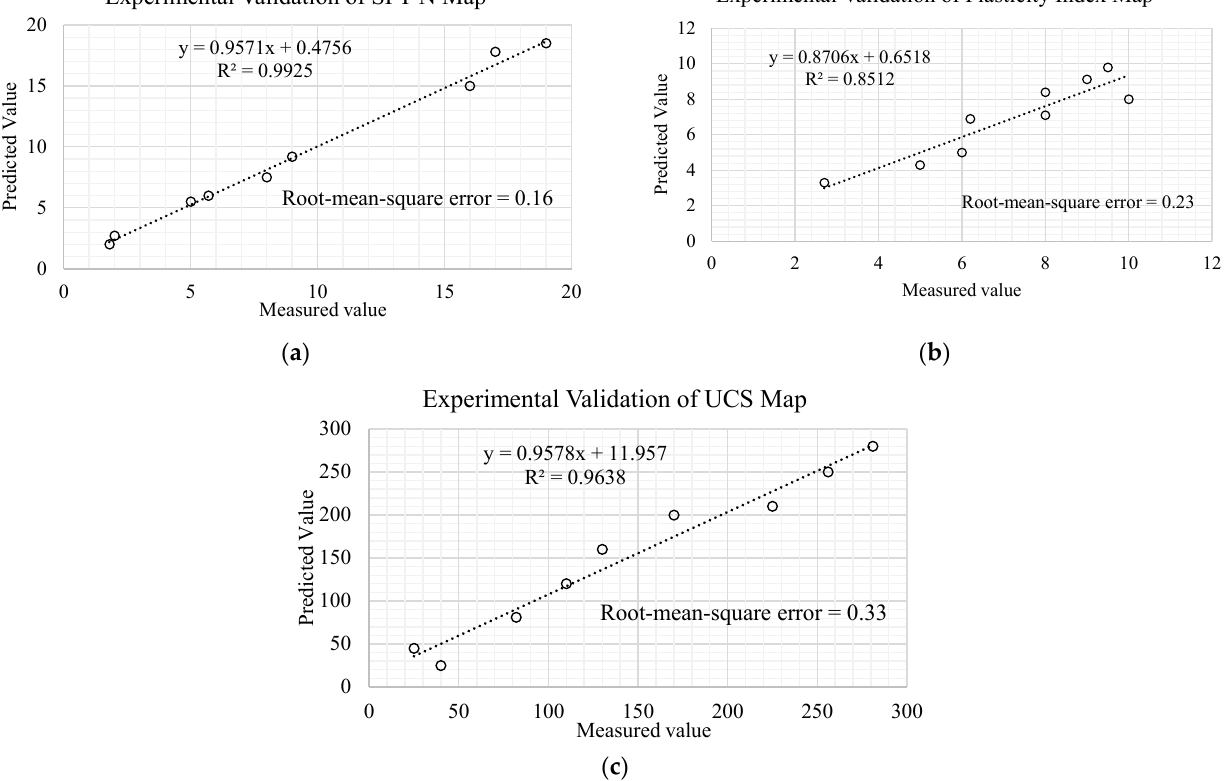
Figure 6. Experimental Validation of Generated maps in Figure 5, ( a ) validation of the SPT map, ( b ) validation of the plasticity index map, and ( c ) validation of the UCS map.